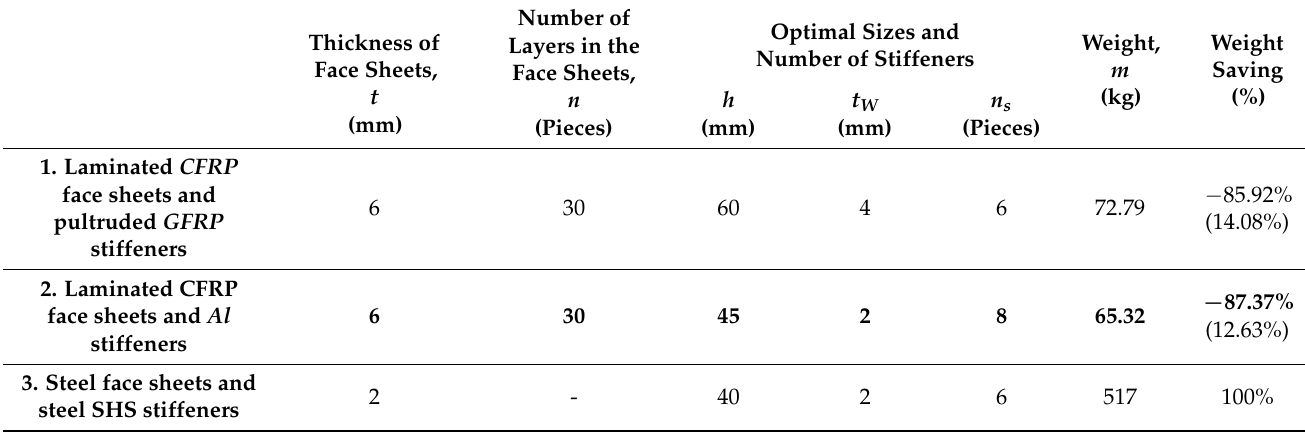
Table 6. Comparison of the three weight-optimized multicellular plate